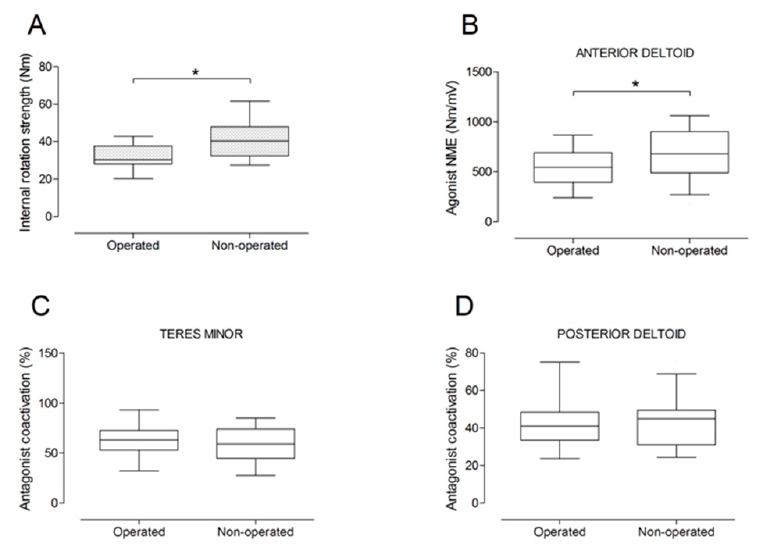
Figure 8. Box and whisker plots of shoulder internal rotation strength ( A ), agonist neuromuscular efficiency (NME) of anterior deltoid muscle ( B ), antagonist coactivation of teres minor ( C ) and posterior deltoid ( D ) muscles by side. The horizontal line in the box represents the median, the height of the box represents the interquartile range, and the distance between the opposite ends of the whisker represents the 10 th –90 th percentile. *Operated < non-operated ( p < 0.05).